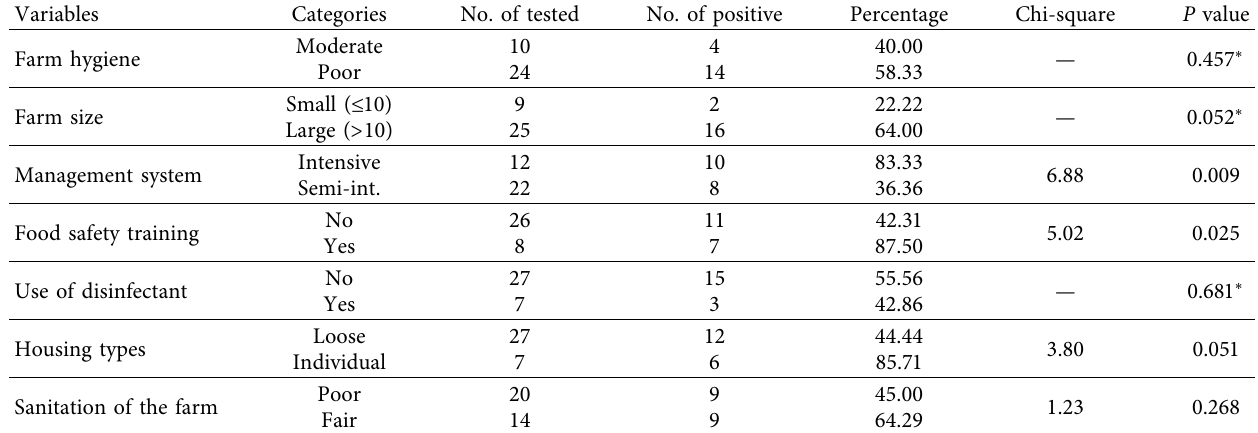
Table 3: Results of the analysis of the association between the prevalence of Staphylococcus aureus and potential risk factors in dairy cattle